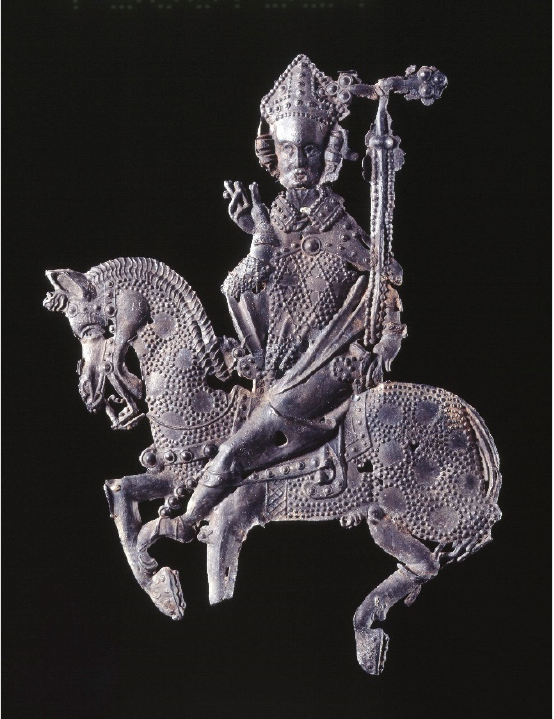
Figure 1. Pilgrim badge, lead alloy, height 93 mm, width 76.9 mm, depth 3.8 mm. ©The Trustees of the British Museum.